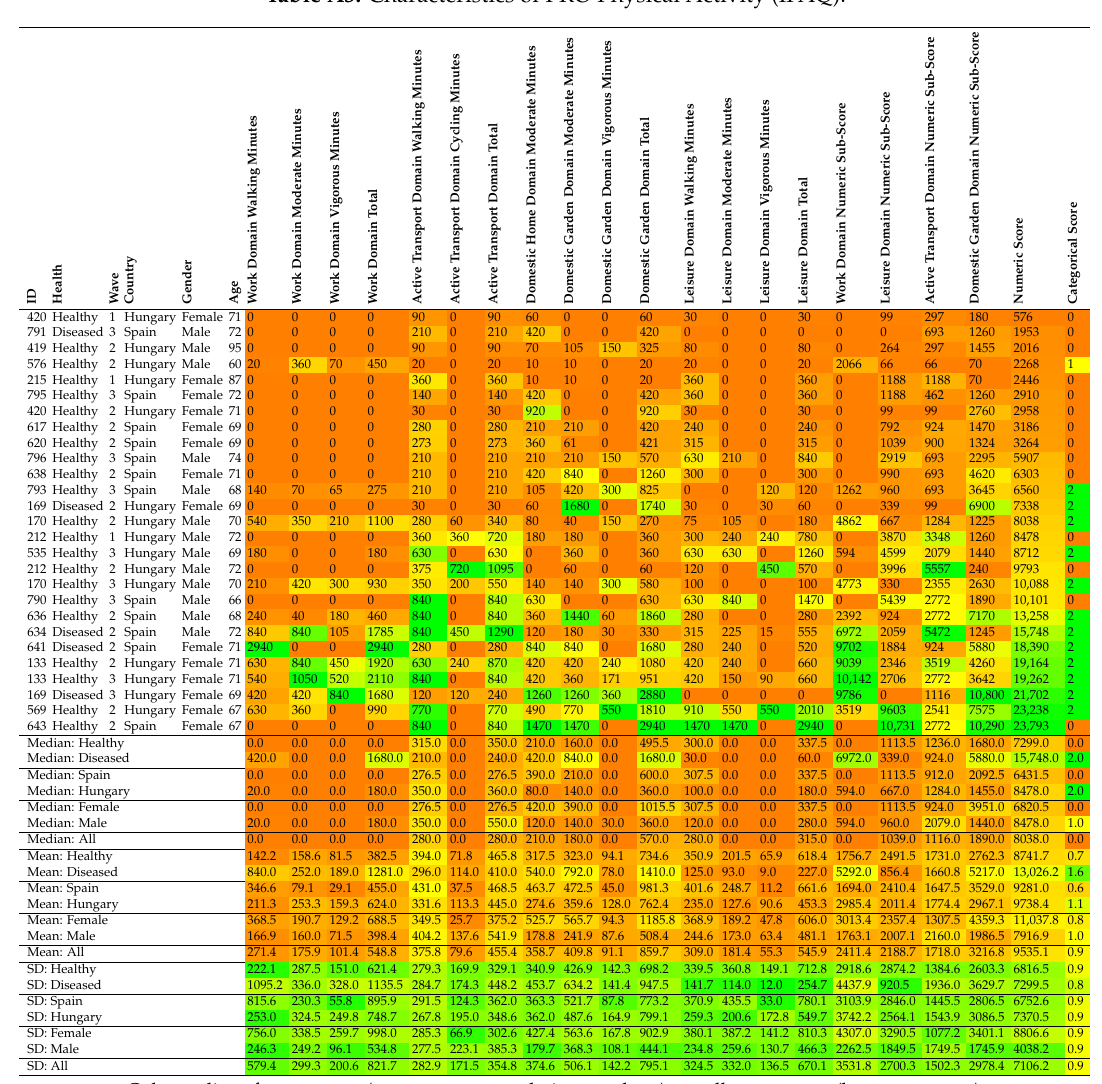
Color coding: from orange (worse outcome relative to others) to yellow to green (better